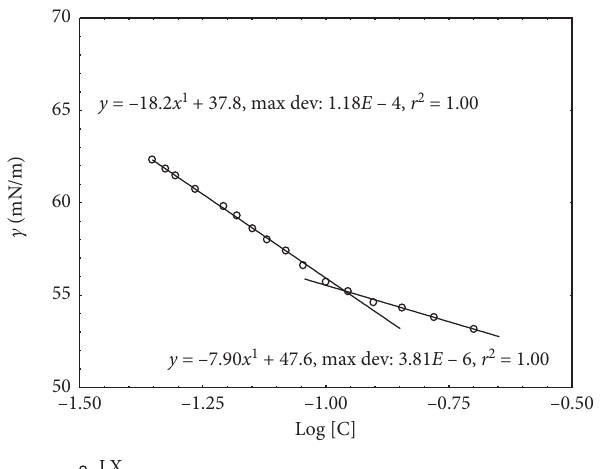
Figure 10: Variation of the slope with soap solutions.